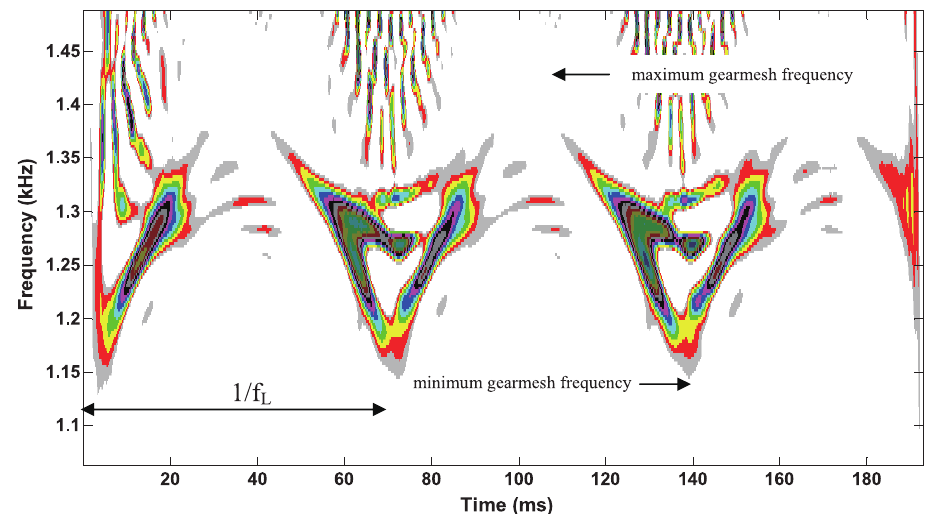
Fig. 15. Details of the SWVD around 3 × f gm for a time varying load.